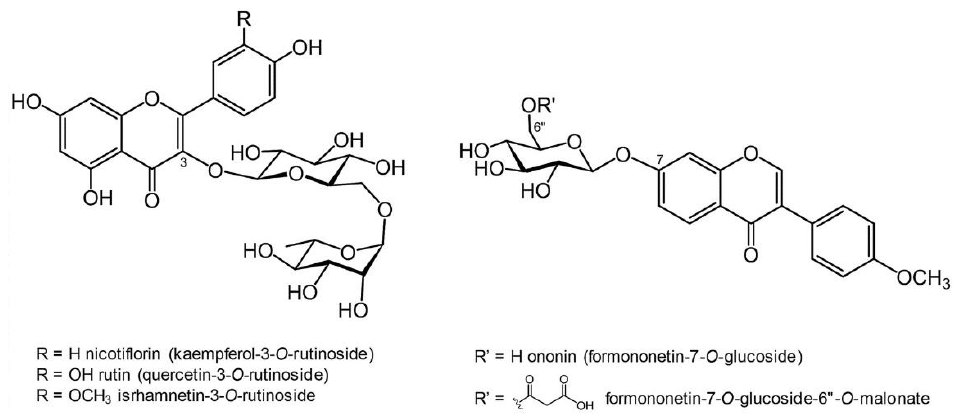
Figure 1. Chemical structure of the most abundant flavonoids detected in the H. coronarium extract. Rutin (quercetin-3- O -rutinoside) was the most abundant compound (26.3% of the total extract), followed by nicotiflorin (kaempferol-3- O -rutinoside), which was detected as 13.3% of the total extract. Ononin (formononetin-7- O - glucoside) and its 6” - O -malonyl de- rivative were also detected in relatively high amounts, at 7.8% and 9.2%, respectively. A minor amount of isorhamnetin-3- O -rutinoside (4.8%) was also quantified in the extract. The tannins were predominantly of the prodelphinidin type, dominated by cis ex- tender units and trans terminal units. The prodelphinidin:procyanidin ratio was about 85:15, with a mean degree of polymerization of about 23 units. All of these results were in agreement with the data previously reported for H. coronarium collected in Southern Italy [25].